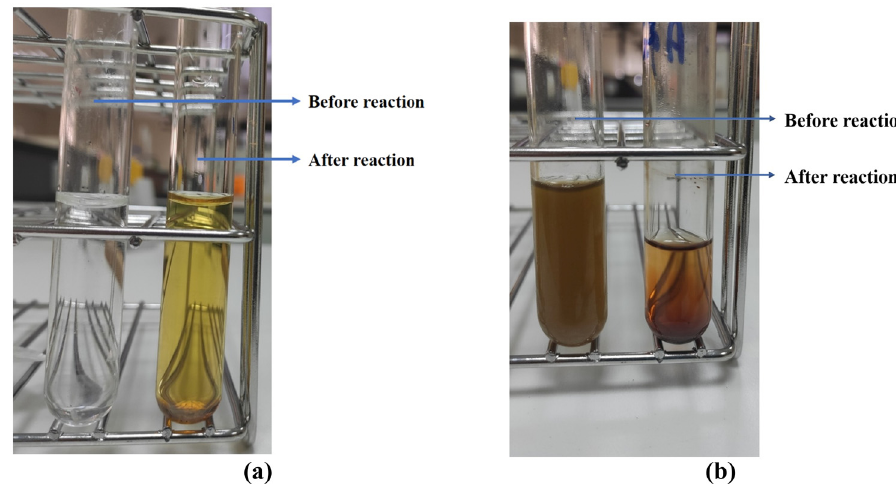
Figure 1: Color change before and after AgNP formation using starch ( a ) and dry microalgae biomass ( b ) as a